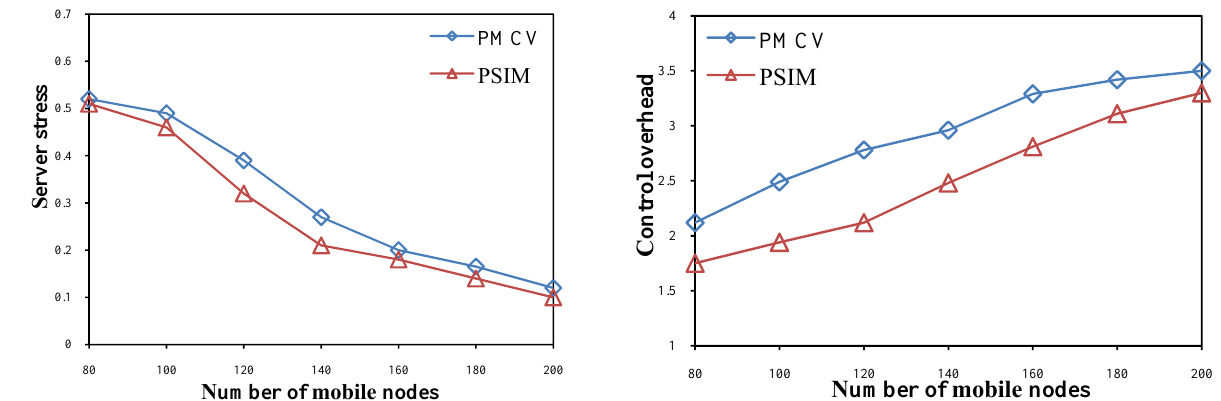
Figure 5: Server stress versus mobile nodes number Figure 6: Control overhead versus mobile nodes num-